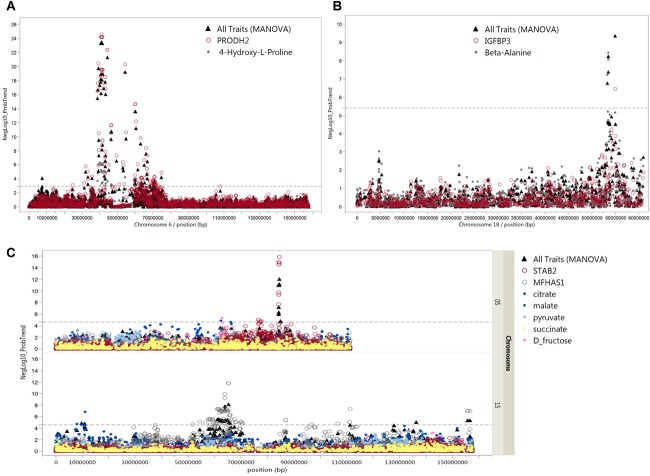
Pleiotropic associations of metabolites and mRNAs. Manhattan plots of pleiotropic associations between metabolites and mRNA expression. The pleiotropic association of these transcripts and metabolites (all traits) was significant (FDR ≤ 5%). (A) cis-eQTL of PRODH2 and mQTL for trans-4-hydroxy-L-proline in close vicinity on chromosome 6, (B) cis-eQTL of IGFBP3 and mQTL for beta-alanine in close vicinity on chromosome 18, and (C) cis-eQTL of STAB2 on chromosome 5 and MFHAS1 on chromosome 15 with mQTL for citrate, malate, pyruvate, succinate, and D-fructose. The x-axis indicates chromosome locations and y-axis shows –log10 of the p-values of multivariate analysis of variance (MANOVA). The dashed line shows the levels of p-values which are significant at 5% FDR.